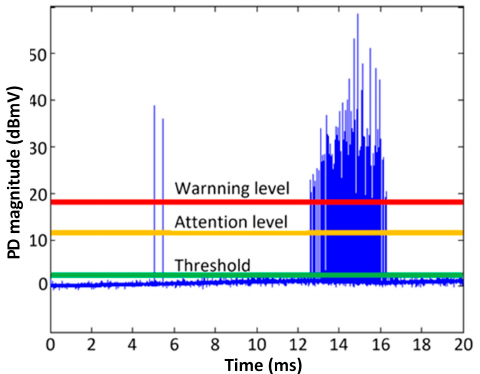
Figure 16. The three levels determined by the sensor unit.